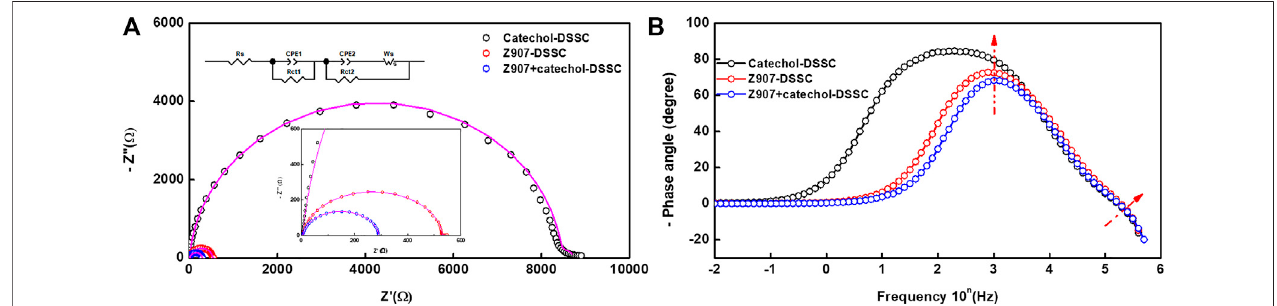
FIGURE 5 | Electrochemical impedance spectroscopy (EIS) data. (A) Nyquist plot and (B) Bode phase plot of the devices in the dark employing potentials according to the open-circuit voltages. Insert is the Nyquist plot equivalent circuit